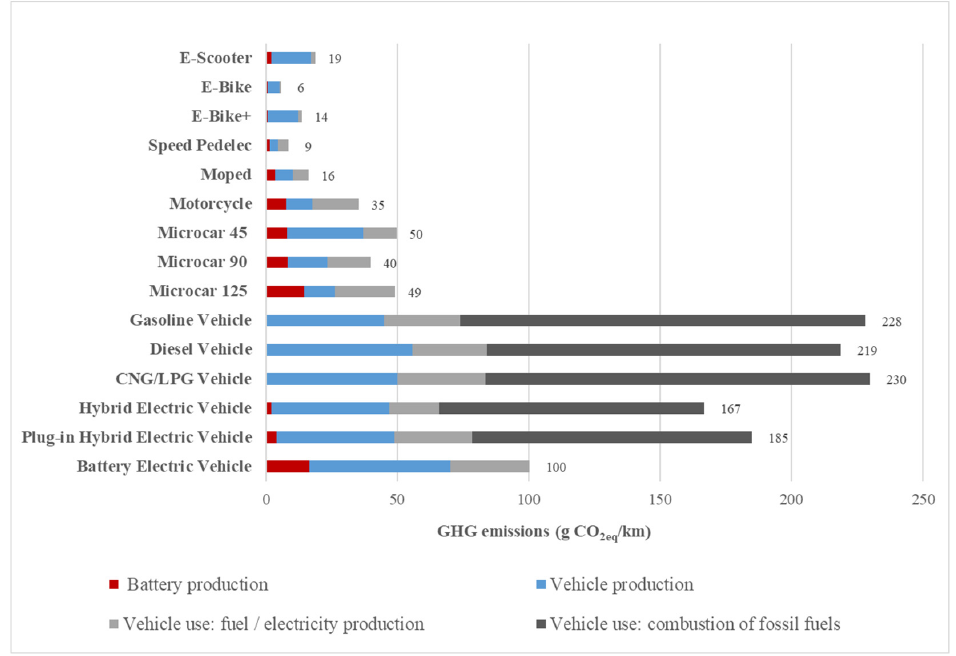
Figure 4. LCA emissions per kilometer of LEVs and passenger cars for baseline scenario. When analyzing the substitutable trips with low-emission LEVs, the average greenhouse emissions of the LEVs (substituted mileage weighted average) is 24 g CO 2eq /km including vehicle production. This is only 12% of the replaced passenger car greenhouse gas emissions of 203 g CO 2eq /km. The average passenger car emissions represent the vehicle stock composition as described in Section 2.3. This difference results in a high emission reduction potential. With the identified mileage substitution potential of 50% (see Section 3.1), an overall saving of 44% would be achieved compared to the use of passenger cars on these trips. In absolute numbers, this amounts to 157 kilo tons CO 2eq per day compared to 356 kilo tons CO 2eq per day. This is equivalent to a reduction of 58 Mio tons CO 2eq per year (Figure 5). Overall, all LEV types contribute to this emission reduction potential with a slightly higher potential for small two-wheelers compared to microcars, mopeds, and motorcycles (Figure 5). This can be understood with the fact that even with similar passenger car mileage substitution for e-scooters, e-bikes, and speed pedelecs when compared to microcars, they save more emissions on LCA and tank-to- wheel basis (Figure 5), given their lower LCA emissions per kilometer (Figure 4). When evaluating the reduction potential that is allocated to the transport sector, only emissions on a tank-to-wheel basis would be considered. The analysis of the emission reduction potential with the tank-to-wheel system boundary leads to savings of 40 million tons CO 2eq per year (Figure 5), with e-bikes having the highest contribution.